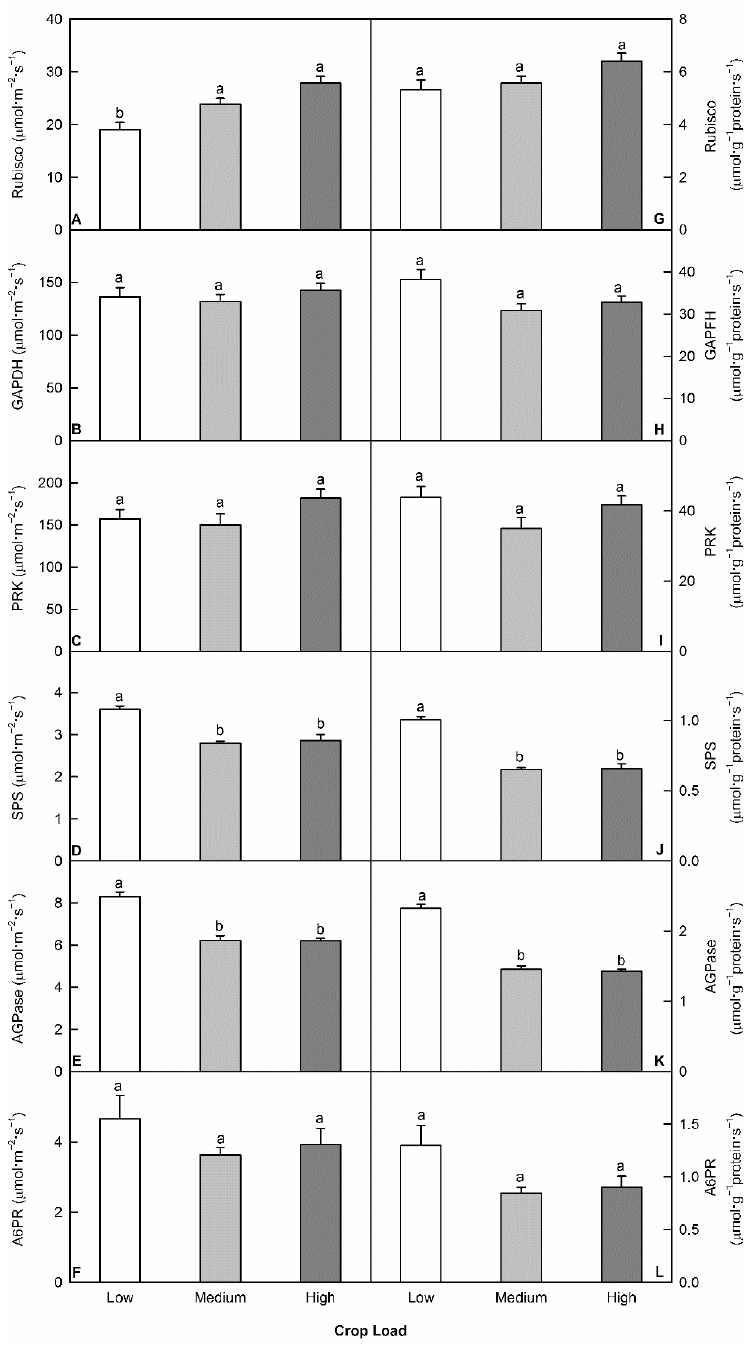
Figure 5. Effects of crop load on the activities of key enzymes involved in carbon assimilation and metabolism in leaves at noon, expressed on leaf area and protein basis: Ribulose-1,5-bisphosphate carboxylase/oxygenase (Rubisco, A and G ), NADP-glyceraldehyde-3-phosphate dehydrogenase (GAPDH, B and H ), phosphoribulokinase (PRK, C and I ), sucrose phosphate synthase (SPS, D and J ), ADP-glucose pyrophosphorylase (AGPase, E and K ), and aldose-6-phosphate reductase (A6PR, F and L ). Each bar is mean ± SE ( n = 5). Different letters above the bars indicate a significant difference for Tukey’s HSD test at p < 0.05.